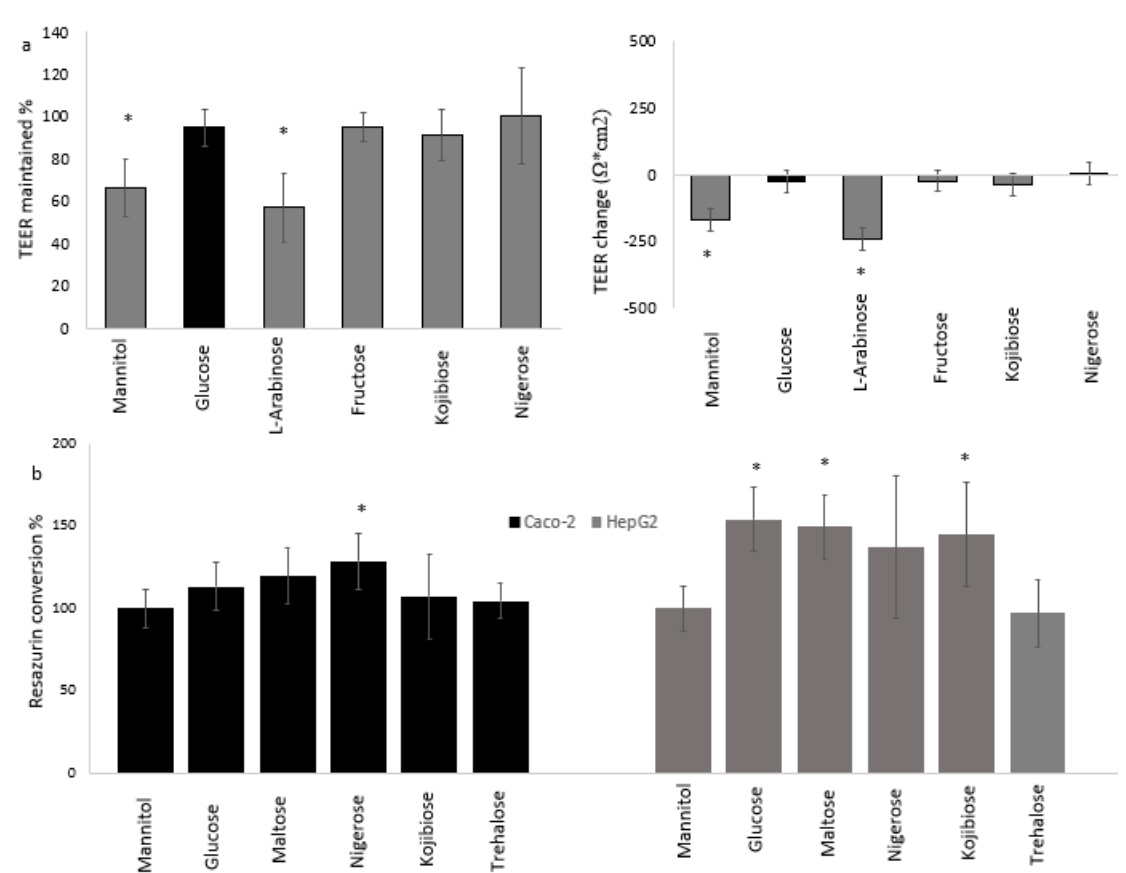
Figure 4. The effect of 24-h sugar exposures in sugar-free medium on TEER and resazurin conver- sion. ( a ) shows the effect of 55 mM monosaccharides or half the concentration for disaccharides on TEER in (as % maintained or absolute change compared to glucose) in Caco-2 cells. ( b ) shows the effect of 28 mM monosaccharides or half the concentration for disaccharides on resazurin conversion (shown as % relative to the mannitol control). Data were generated from experiments with 3 independent plates, generating a total of 11 ( a ) or 10 ( b ) well-replicates per condition, and are presented as mean ± standard deviation with * indicating a statistically significant ( p < 0.05) difference compared to glucose.